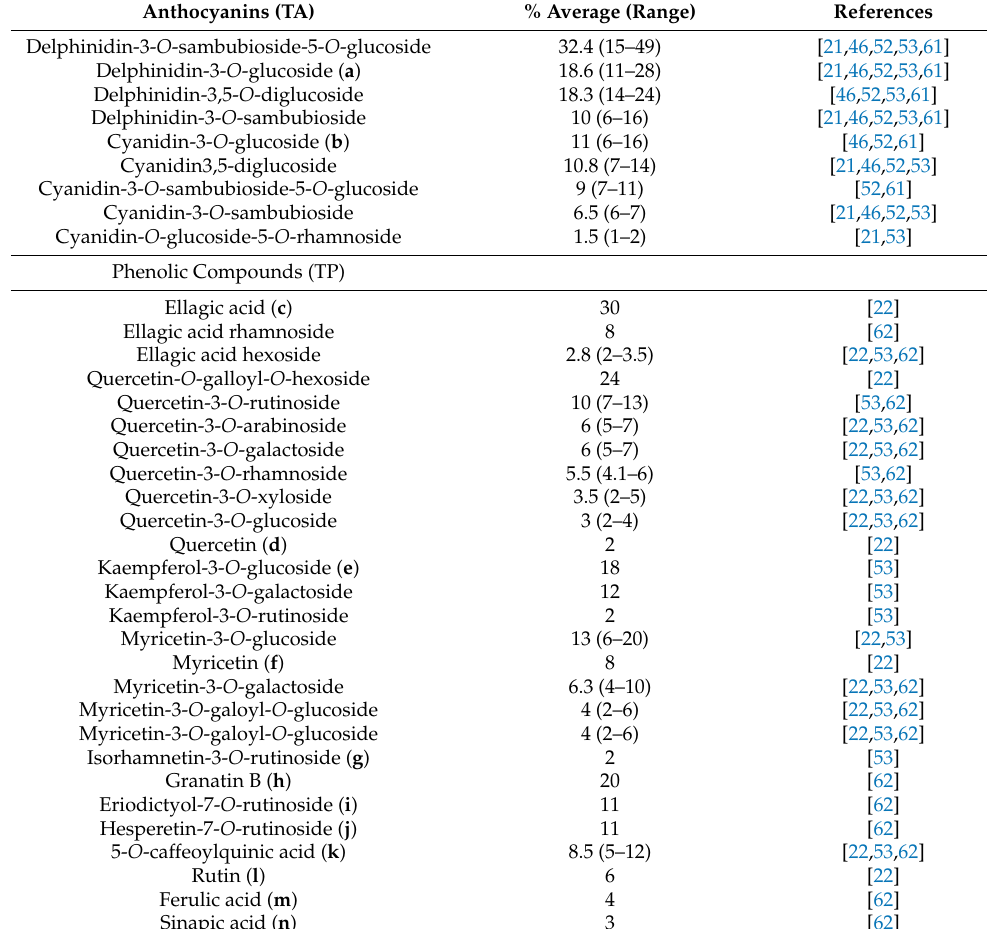
Table 1. Anthocyanins and phenolic compounds identified and quantified in Maqui fruit extracts. Anthocyanins (TA) % Average